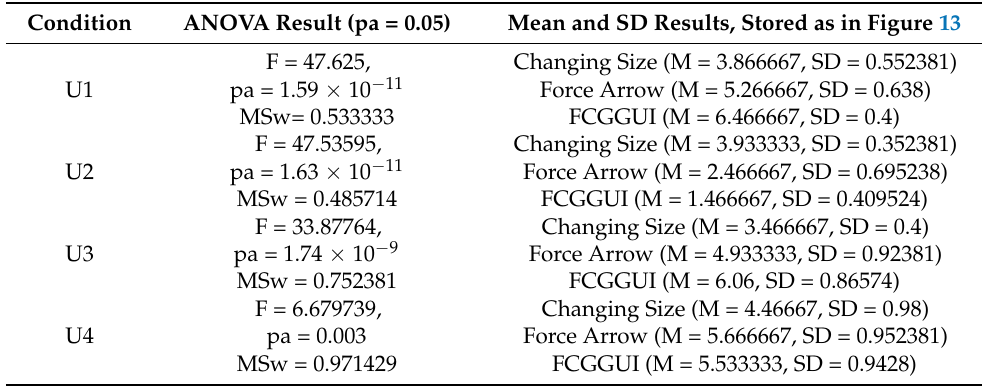
Figure 14. Results of average points of the questionnaire for the evaluation of user interaction. Table 7. Results of the ANOVA test of the interaction in Experiment 1.